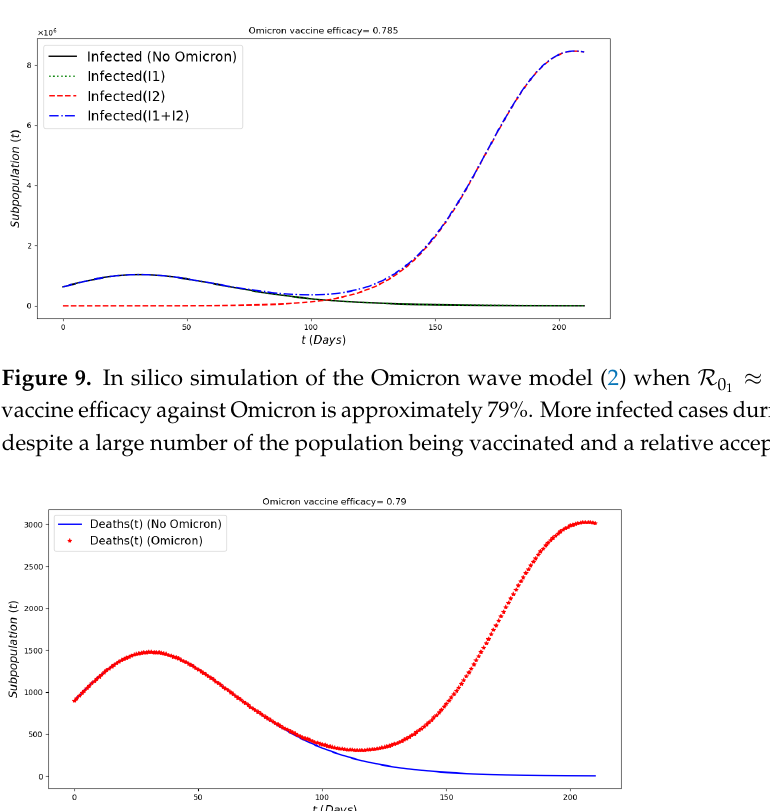
Figure 10. In silico simulation of the Omicron wave mathematical model (2) when R 0 R ≈ 1.74 and vaccine efficacy against Omicron is approximately 79%. More deaths during the 0 2 Omicron wave, despite a lower case fatality rate for Omicron, large number of population vaccinated and a relative acceptable vaccine